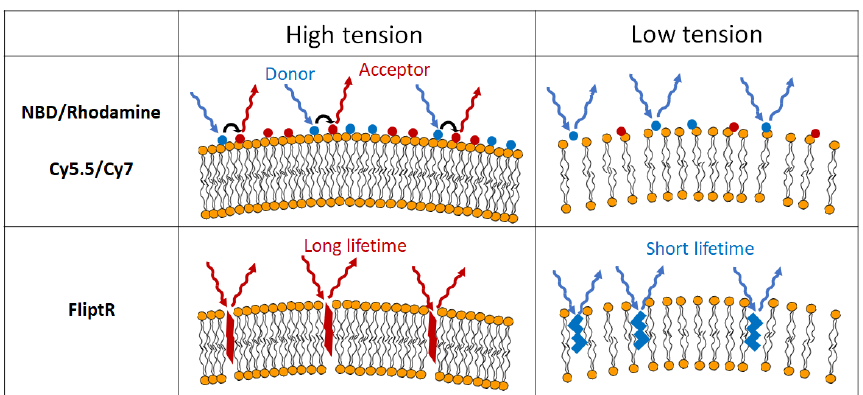
Figure 2. Schematic illustration of visualizing membrane tension by fluorescent membrane